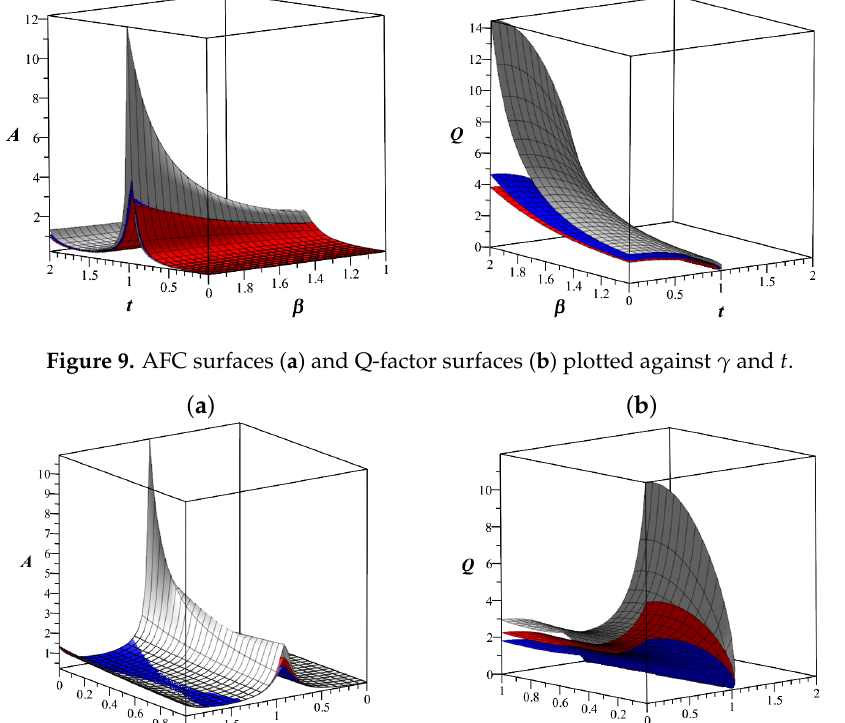
Figure 10. AFC surfaces ( a ) and Q-factor surfaces ( b ) plotted against β and t